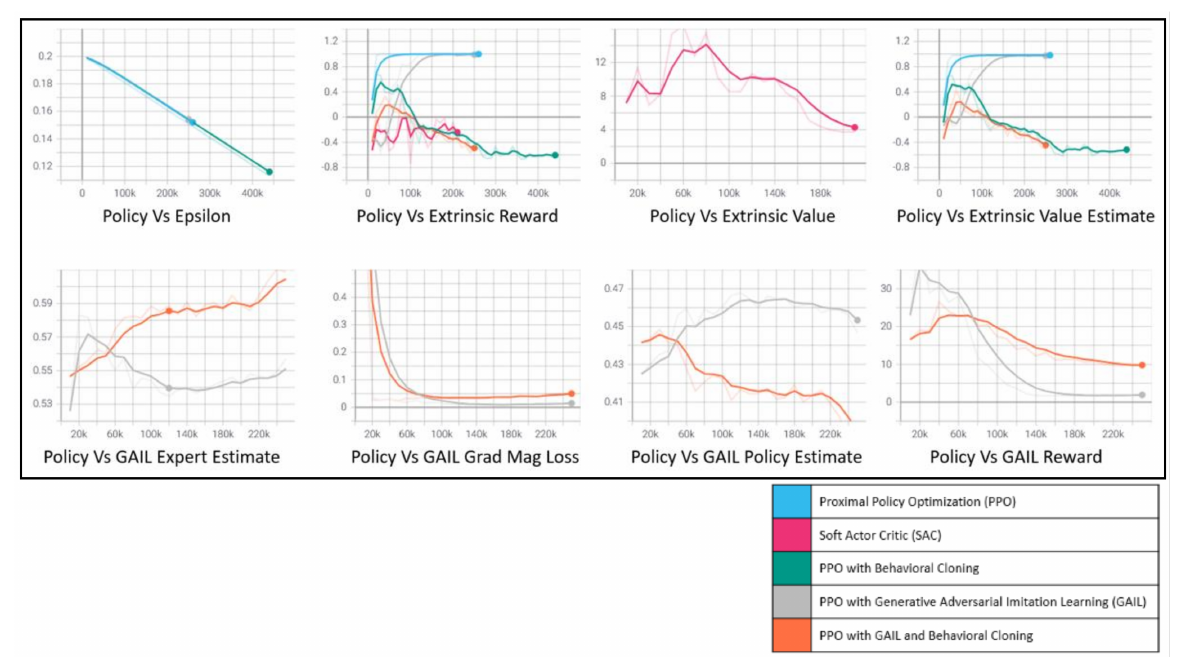
Figure 21. Model-specific parameter